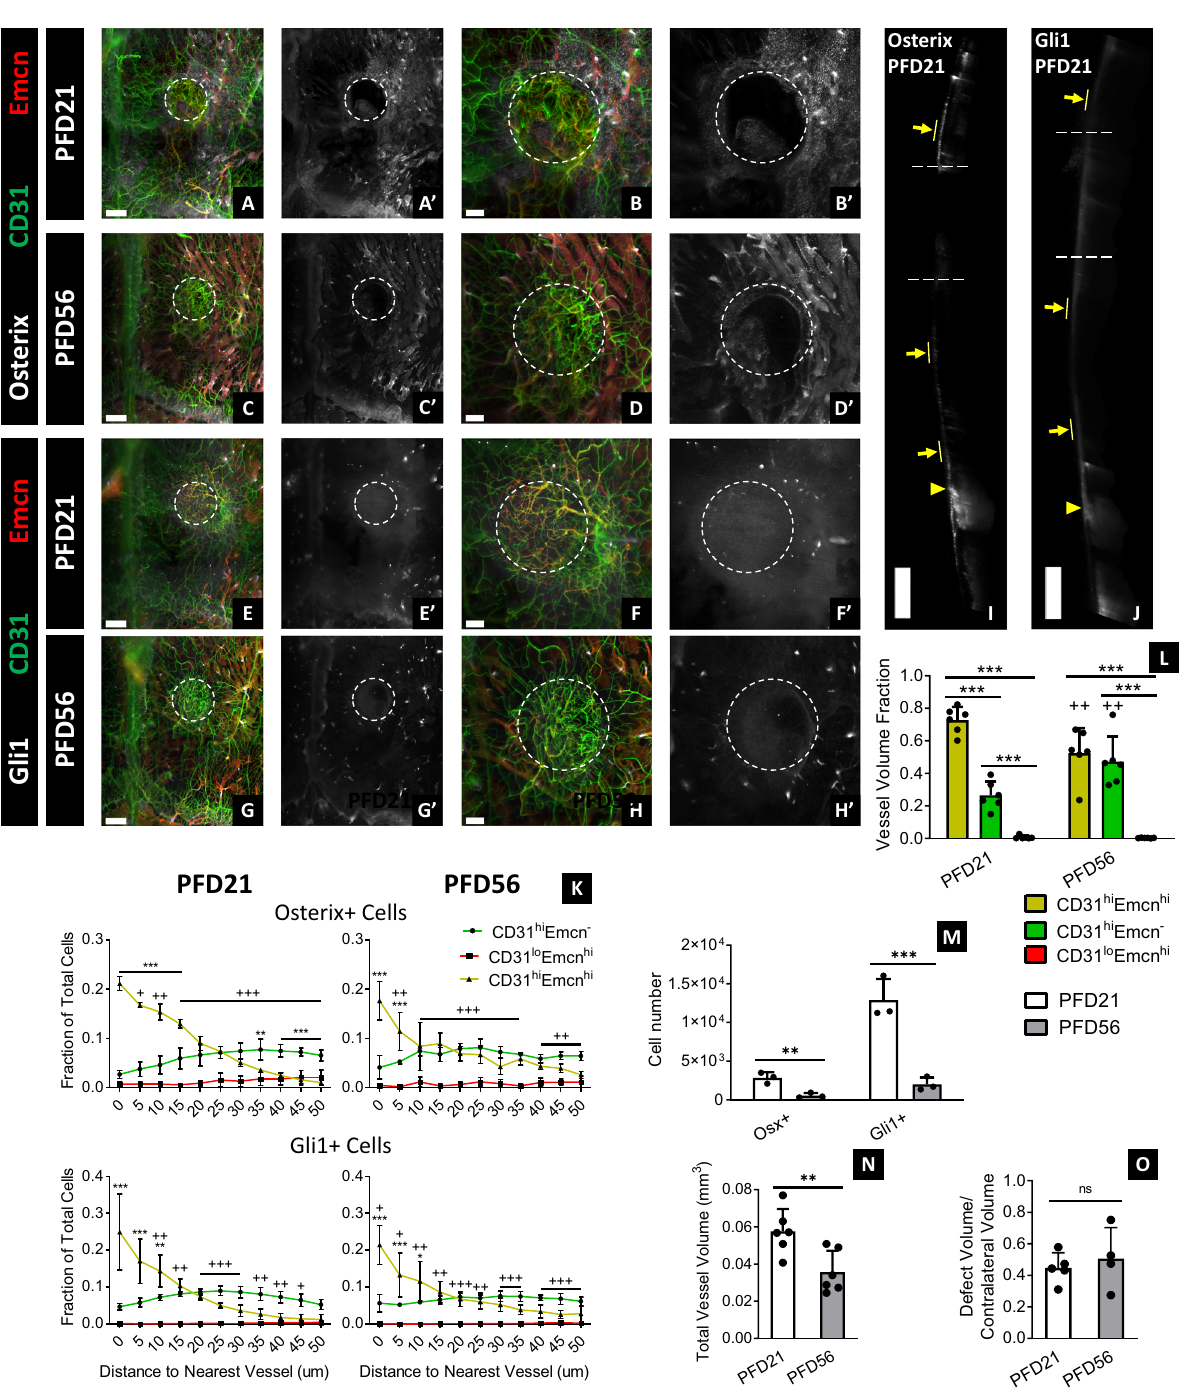
Fig. 6 CD31 hi Emcn hi vessels and skeletal progenitors expand and in fi ltrate into subcritical-sized defects during healing. A – H Blood vessels ( A – H ), Osterix + progenitors ( A – D, A' – D' ), and Gli1 + progenitors ( E – H , E' – H' ) inside and around 1-mm parietal bone defects at PFD21 ( A , B , E , F ) and PFD56 ( C , D , G , H ). The dotted circle marks the defect region. I , J Expansion of Osterix + and Gli1 + progenitors in the periosteum (yellow arrows) nearby the defect region (dotted lines) and sutures (yellow arrowheads) at PFD21. Progenitors were sparsely populated in the dura mater — the only portion of the calvarium that remained intact following defect injury. Results were replicated in 3 calvaria for each timepoint and staining combination (12 total calvaria). K Spatial relationship of skeletal progenitors to different vessel phenotypes at PFD21 and PFD56 ( n = 3). L – N Fractional vessel phenotype volume ( L ), skeletal progenitor number ( M ), and total vessel volume ( N ) in the defect at PFD21 and PFD56 ( n = 6 for L , N ; n = 3 for M ). O MicroCT quanti fi cation of defect to contralateral bone volume ratio at PFD21 and PFD56 ( n = 4). Data are mean ± SD. Statistics were performed using a two-way ANOVA with Bonferroni post-hoc test ( K – M ) or two-tailed t -test ( N – O ). *** p < 0.001, ** p < 0.01, * p < 0.05 where designated or between CD31 hi Emcn hi and CD31 hi Emcn − vessels in K ; +++ p < 0.001 between CD31 lo Emcn hi and CD31 hi Emcn − vessels. Exact p -values for two-tailed t -tests: N p = 0.0094, O p = 0.5660. Scale bars: 500 μ